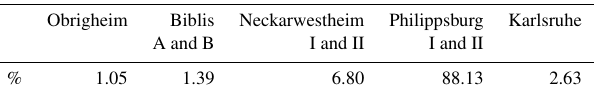
Table 3. Relative average (cid:49) 14 C nuclear contribution in Heidelberg from 1986 to spring 2011 (shutdown of Philippsburg